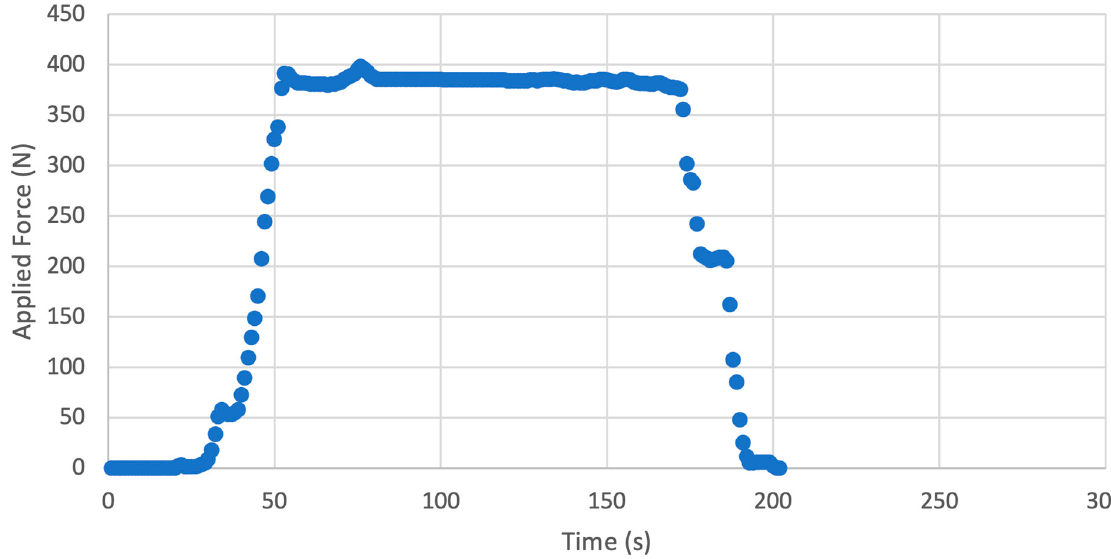
Figure 7. Direct screw press applied force as a function of time.